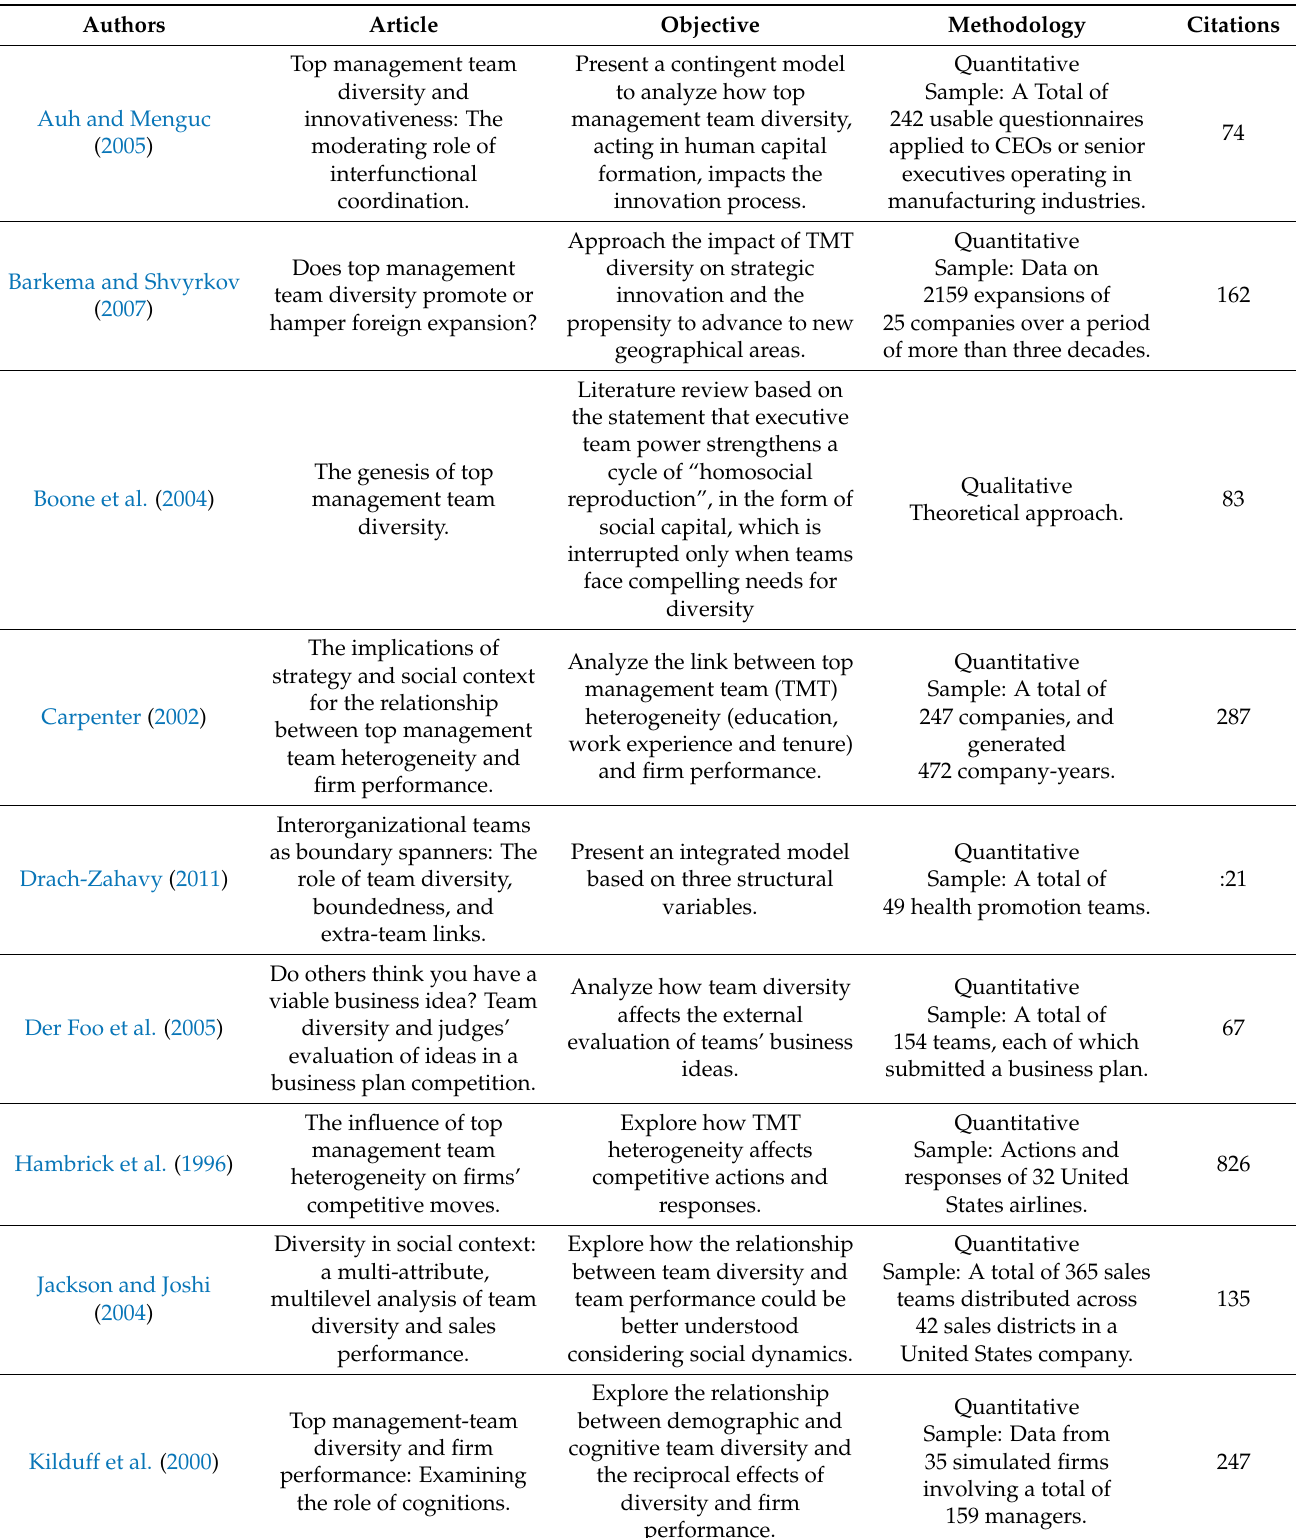
Table 5. Authors in Diversity Effects